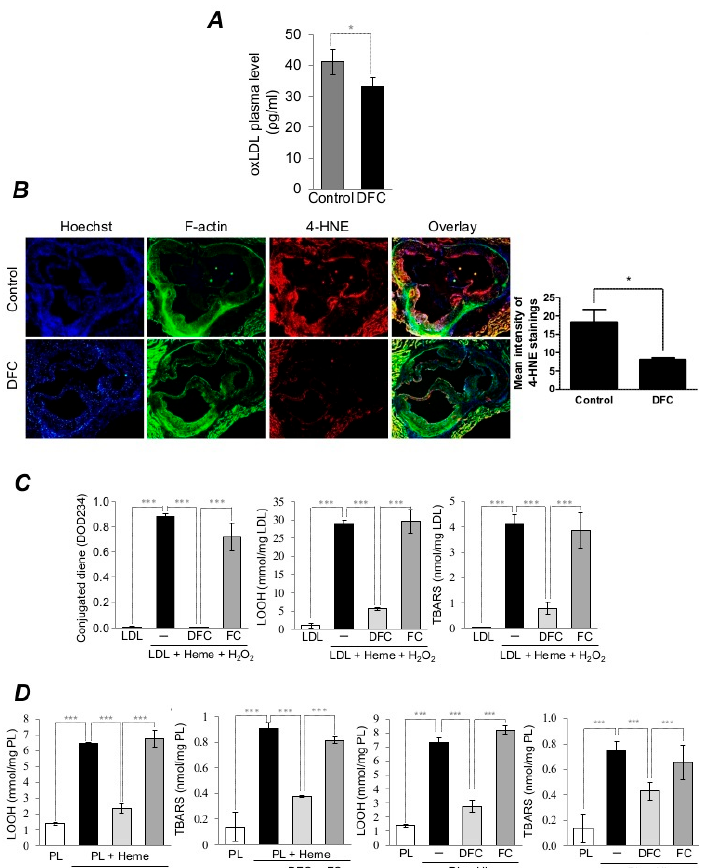
Figure 2. DFC inhibits lipid peroxidation of plaque lipids and LDL in ApoE − / − mice and suppresses heme / hemoglobin-catalyzed oxidation of lipid of human atheromatous plaque and LDL. Eight-week-old ApoE − / − mice were fed ad libitum with an atherogenic diet containing 5% fat and 1.25% cholesterol and divided into DFC group receiving 160 mg / kg intraperitoneal DFC and control group receiving physiological saline every second day for 8 weeks. ( A ) Quantitative analysis of plasma oxidized LDL (oxLDL) levels of DFC-treated and control mice ( n = 5) are shown. ( B ) Immunofluorescent analysis of lipid peroxidation in the aortas of DFC-treated and control mice. Aortas (5 per group) were stained for DNA (Hoechst 33258, blue), F-actin (cytoskeleton, phalloidin-FITC, green) and 4-Hydroxynonenal (4-HNE, AF647, red). Quantification of 4-HNE mean intensity was performed with Image J software. Scale bar: 0.2 mm. ( C ) Conjugated dienes, lipid hydroperoxides (LOOH) and thiobarbituric-acid-reactive substances (TBARs) contents of LDL samples exposed to heme (5 µ mol / L) and H 2 O 2 (75 µ mol / L) in the presence or absence of DFC (50 µ mol / L) or FC (50 µ mol / L) were measured. ( D ) LOOH and TBARs contents of plaque lipids (1 mg / mL) exposed to heme (5 µ mol / L) or Hb (5 µ mol / L) in the presence or absence of DFC (50 µ mol / L) or FC (50 µ mol / L) were measured. The graph shows the mean ± SEM of three separate experiments. * p < 0.05; *** p <